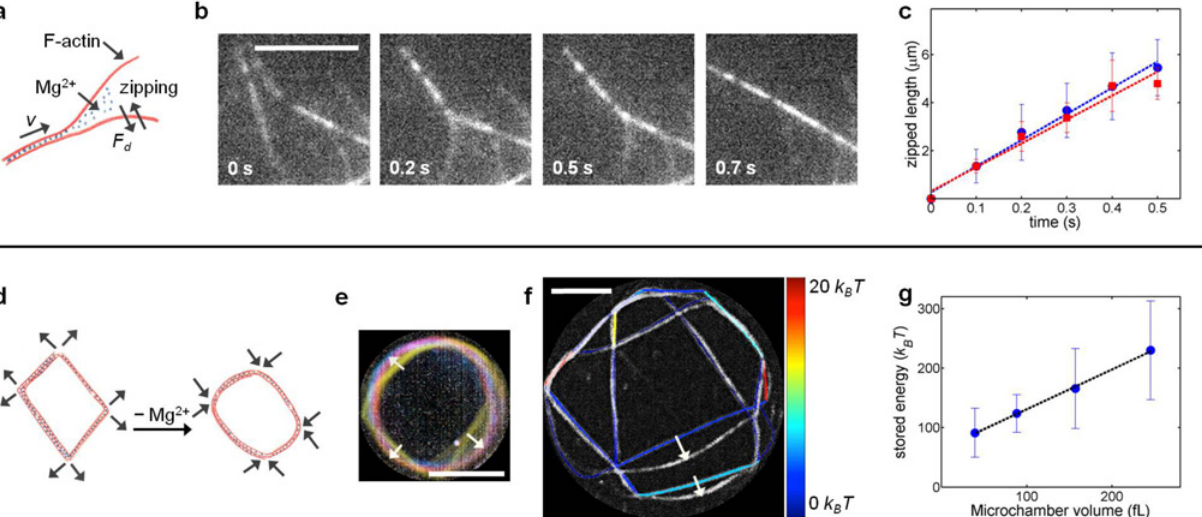
Fig 6. F-actin zipping leading to Mg 2+ -induced stressed actin networks. (a) Sketch of the zipping process showing that actin filaments have to overcome the drag force. (b) Time-lapse images of two single actin filaments zipping together to form an actin bundle. (c) Plot of zipped length against time. (blue circles: zipping of filaments ( n = 14), red squares: zipping of small bundles ( n = 8)). Error bars indicate ± standard deviation. The dashed lines are linear fits to the data. (d) Sketch depicting the energy released during the disassembly of networks subsequently used in buckling of bundles. (e) Network relaxation color-coded in time (from yellow to blue) showing the buckling of bundles (indicated by arrows) during de-bundling. (f) Network under tension (color-coded for the minimum energy stored in each of the links) overlapped on the relaxed network (in greyscale). Arrows indicate some prominent buckling of links. (g) The minimum energy stored in the networks formed in different confinement volumes ( n = 9). Error bars indicate ± standard deviation. The dashed line shows a linear fit. Scale bars represent 5 μ m.